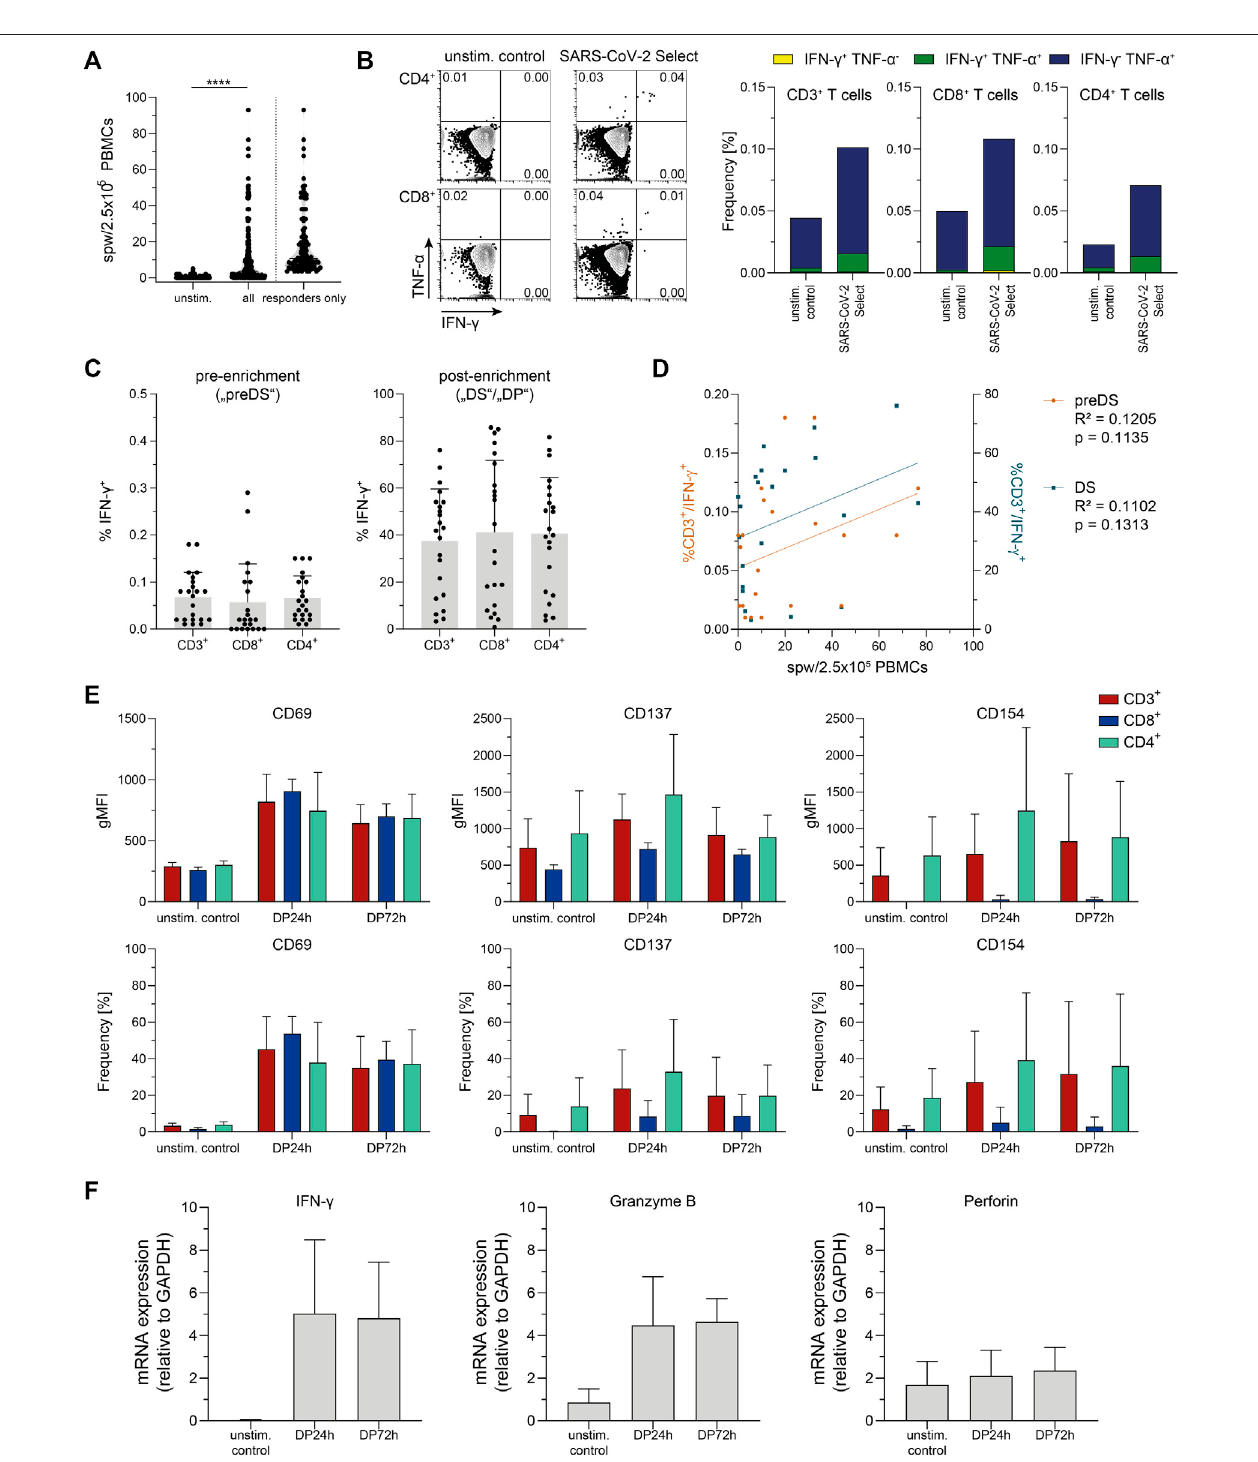
FIGURE 1 | Donor screening and pretesting. (A) Summarized results of donor screening via Interferon-gamma (IFN- γ ) Enzyme-Linked ImmunoSpot (ELISpot) assay, n = 198 (all) and n = 104 (responders only) convalescent COVID-19 patients. unstim.: unstimulated control; spw: spots per well. Data are shown as violin plots, each symbol represents data obtained from one donor. **** p < 0.0001; Wilcoxon matched-pairs signed rank test. (B) Representative FACS plots and summarized results from intracellular cytokine staining in whole blood after stimulation with PepTivator SARS-CoV-2 Select using the SARS-CoV-2 T Cell Analysis Kit (Whole Blood)(MiltenyiBiotec).unstim.control:unstimulatedcontrol;TNF- α :TumorNecrosisFactor-alpha.Dataareshownasmeanofdataobtainedfrom n =12convalescent COVID-19 patients. (C) Summarized frequencies of IFN- γ -secreting T cell subsets detected and magnetically enriched using Cytokine Secretion Assay (CSA); left: pre-